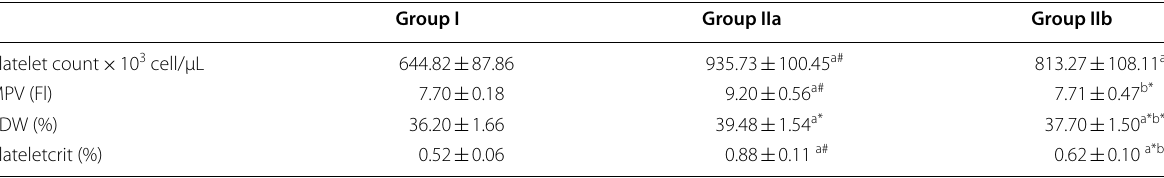
Data are expressed as mean